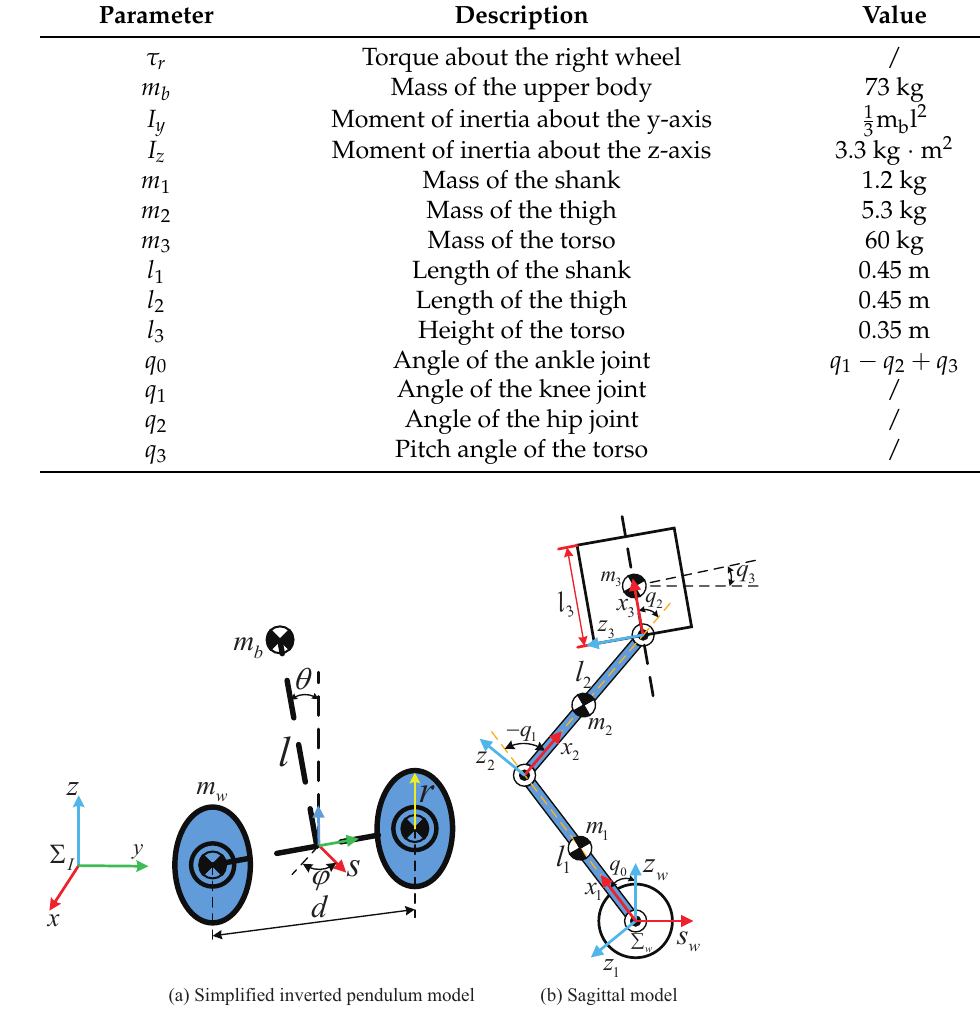
Figure 2. Decoupled model: the VL-WIP model and the floating base upper body mode (sagittal model). Σ w represents the axle coordinate